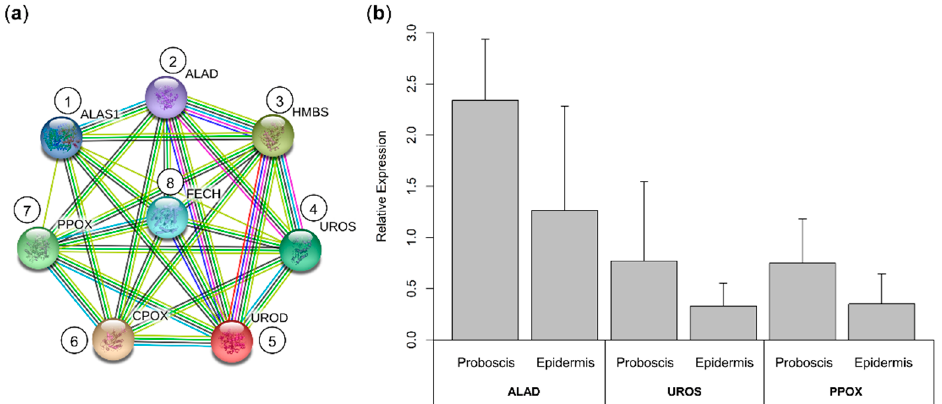
Figure 6. Interaction network of the enzymes involved in heme biosynthesis in the marine annelid Eulalia and validation of RNA-seq by RT-qPCR of a gene subset. ( a ) The eight enzymes involved in the heme biosynthesis pathway were identified in the translated transcriptome. (1) ALAS1, δ -aminolevulinic acid synthase 1; (2) ALAD, δ -aminolevulinic acid dehydratase; (3) HMBS, hydroxymethylbilane synthase; (4) UROS, uroporphyrinogen synthase; (5) UROD, uroporphyrinogen decarboxylase; (6) CPOX, coproporphyrinogen oxidase; (7) PPOX, protoporphyrinogen oxidase; and (8) FECH, ferrochelatase. Protein– protein interactions were retrieved from the STRING database with information from the “heme biosynthesis” subset. ( b ) Validation of RNA-seq data was done for mRNAs coding for ALAD, UROS, and PPOX, using RT-qPCR. Relative expression was determined via the 2 − ∆∆ Ct method following the use of primers designed to amplify the best homology- matched sequences. The results are presented as mean + standard deviation. Despite the trend for overexpression of selected genes in the proboscis, no statistical differences were found between the organs, in accordance with the RNA-seq results.